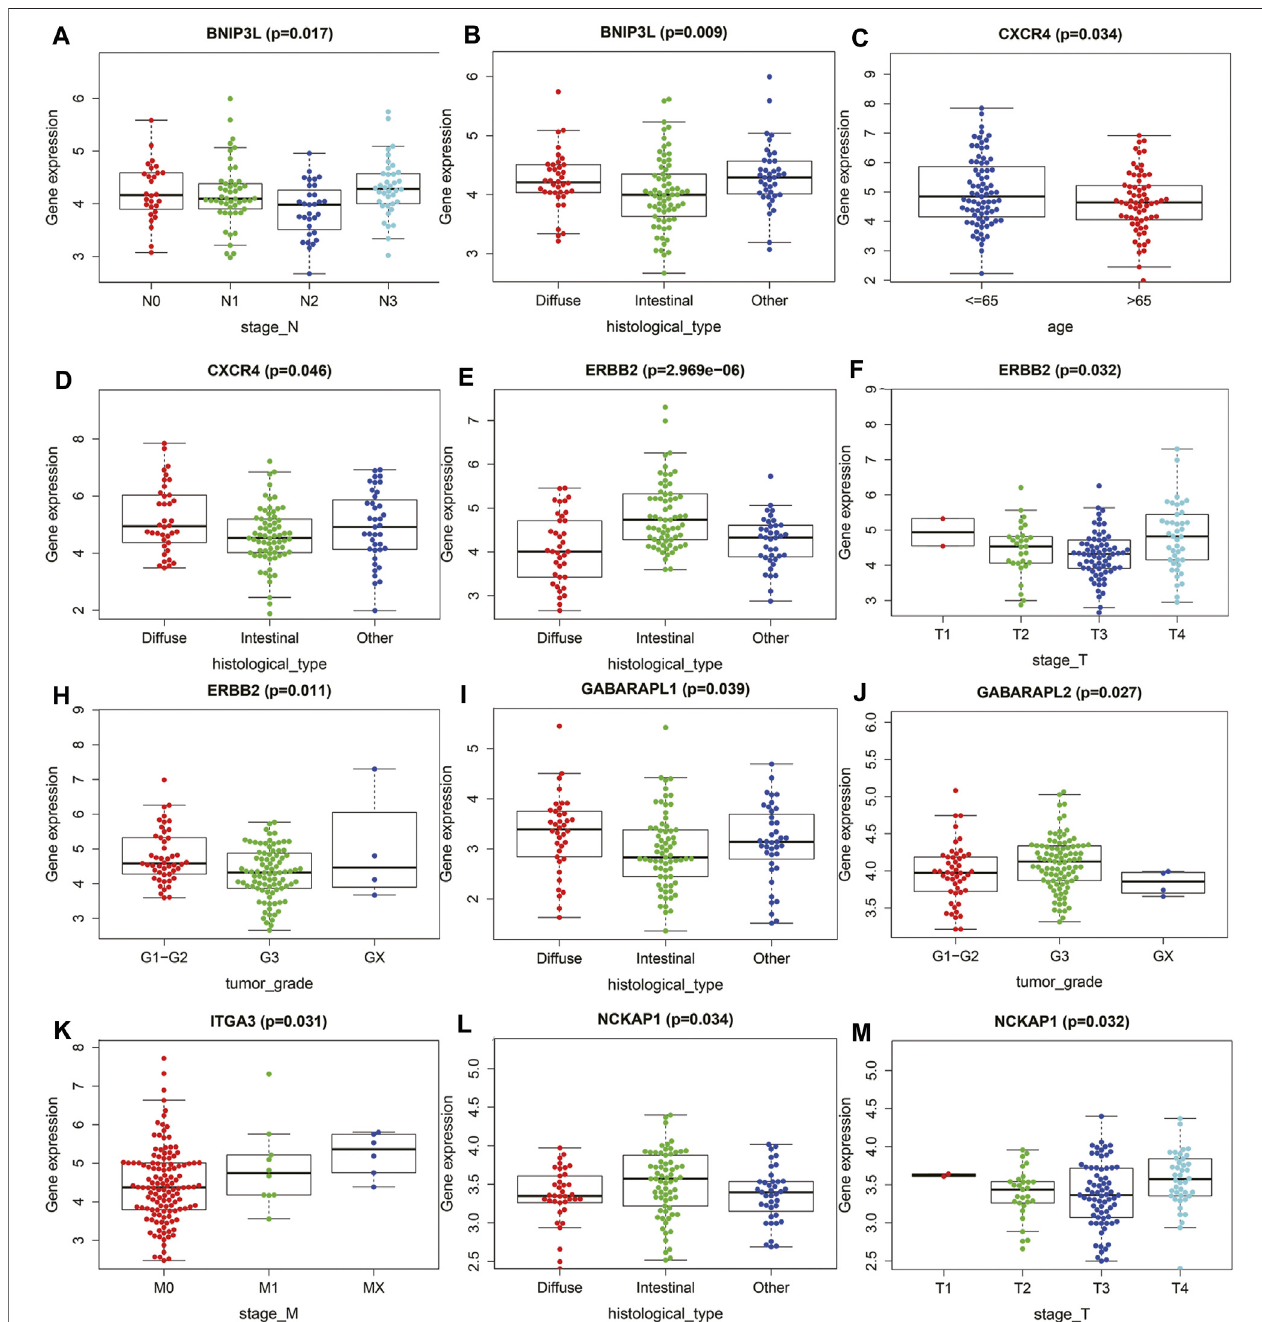
FIGURE4| TherelationshipsbetweentheATGsandclinicopathologicalvariables. (A,B) BNIP3L. (C,D) CXCR4. (E,F,H) ERBB2. (I,J) GABRAPL. (K) ITGA3. (L,M) NCKAP1.